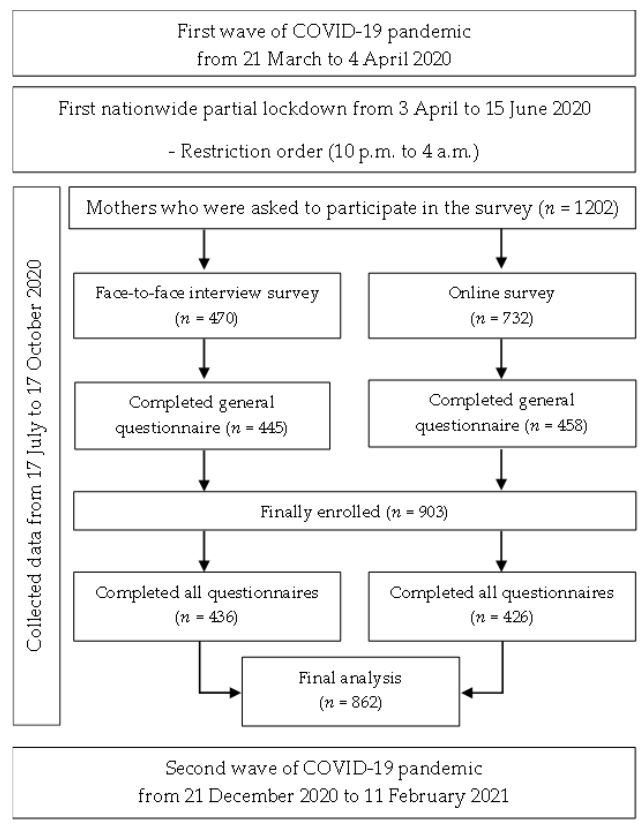
Figure 1. COVID-19 pandemic and lockdown durations in Thailand and period of the online platforms, interviews, and sample size of this study.